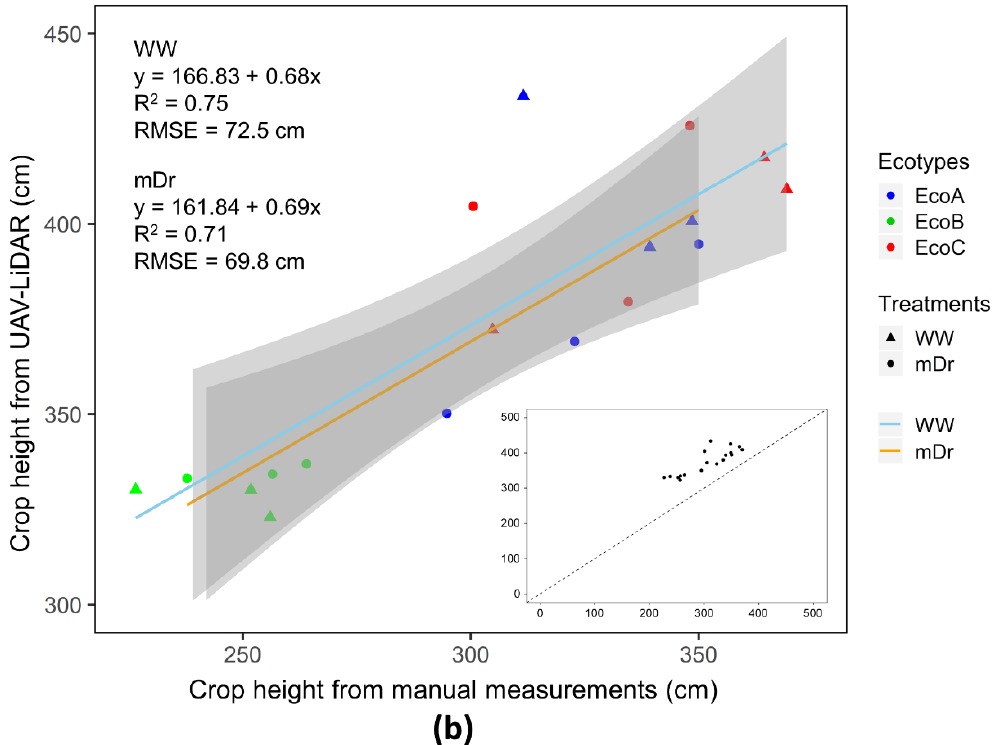
Figure 7. The relationship between manually measured crop height and the height derived from the light detection and ranging (LiDAR) measurements with fitted lines and grey zone representing confidence intervals (95%). ( a ) Linear relationship for all crop ecotypes; ( b ) linear relationship for each of the well-watered (WW) and the natural moderate drought stress (mDr) treatments. The inserts depict all measurements, and the dashed line is the 1:1 line.